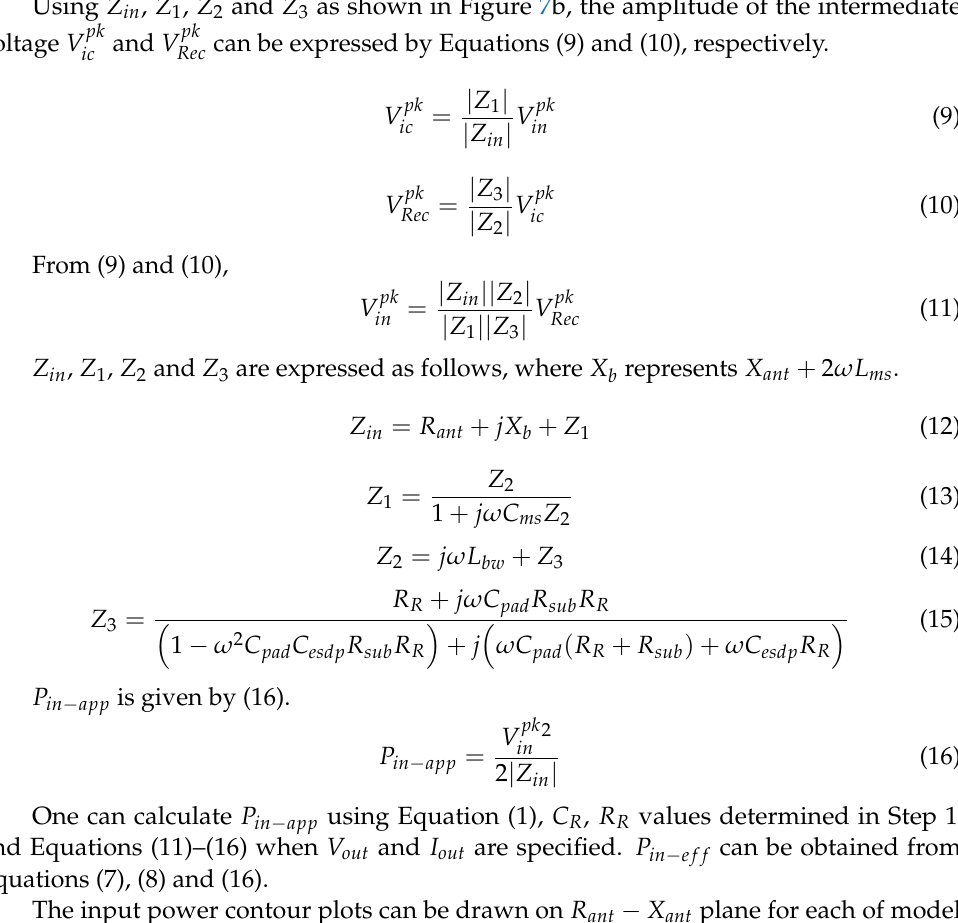
( b ) Figure 9. Antenna candidates: ( a ) dipole antenna and ( b ) circular loop antenna.